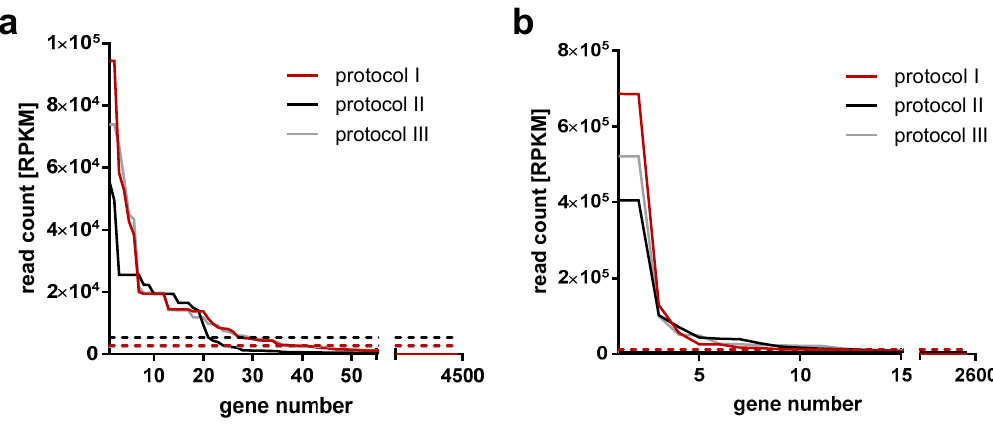
Figure 1. Read distribution in samples analyzed for virion-incorporated transcripts. Highly pure cowpox virus (CPXV) intracellular mature virion (IMV) particles passaged in ( a ) HEp-2 or ( b ) Rat-2 cells were analyzed for transcripts by next-generation sequencing (NGS). Reads mapping to the virus genome and the host genome (human or rat) were sorted by read count (RPKM = reads per kilobase million). Dashed lines: cutoff 90%. Three different protocols were applied for sample preparation: I: RNase digestion, II: no RNase digestion and III: protease and RNase digestion.